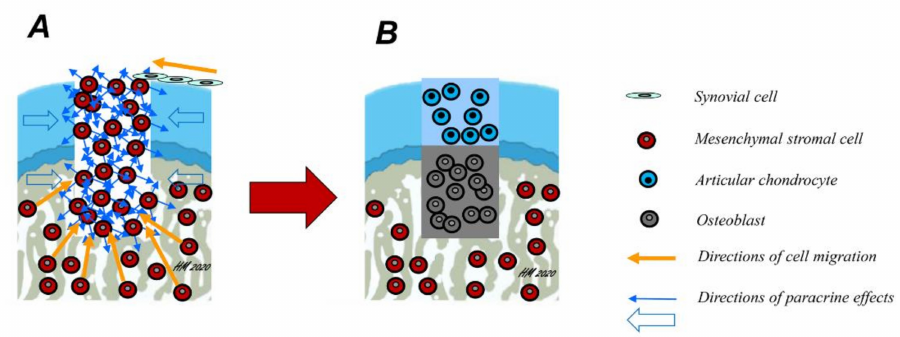
Figure 1. Mechanisms of osteochondral repair. Osteochondral defects involve, by definition, both the articular cartilage and the subchondral bone. Spontaneously, they are mainly repaired by mesenchymal stromal cells (MSCs) arising from the subchondral bone marrow ( A , yellow arrows). However, some cell migration into the defect from synovial cells is also possible. Over time, these cells di ff erentiate either into chondrocytes or osteoblasts and deposit their extracellular matrix (ECM), depending on their location within the osteochondral defect, a mechanism possibly regulated in part by paracrine e ff ects of the cells in the adjacent osteochondral unit (blue arrows). Ideally, a fibrocartilaginous repair tissue forms in the upper part of the defect ( B ), while the subchondral bone is repaired with new